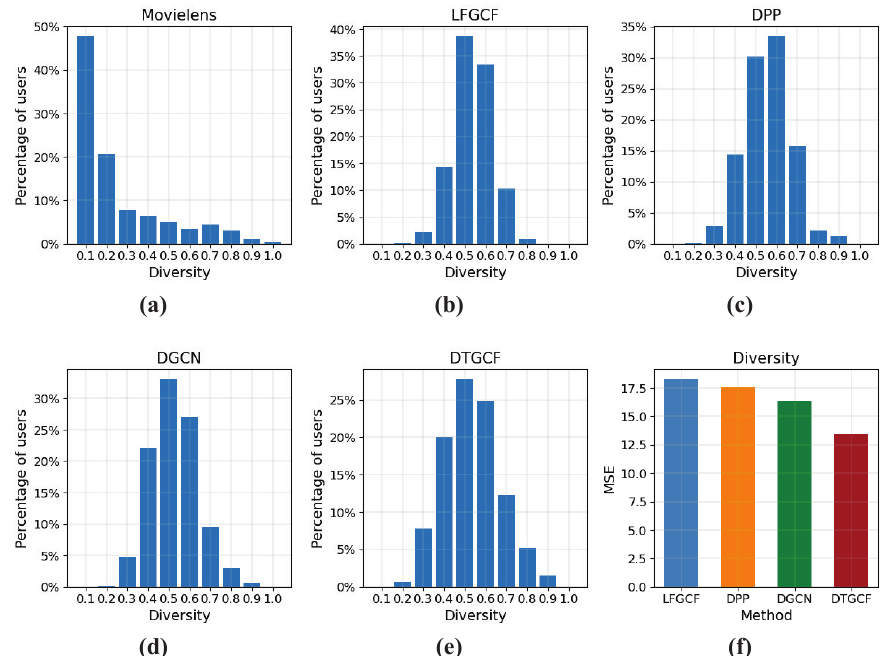
Figure 5. The results of user diversity distribution. ( a ) is the real diversity distribution of users on Movielens 10M; ( b – e ) are the predicted diversity distribution of LFGCF, DPP, DGCN, and DTGCF; ( f ) presents the MSE results of different